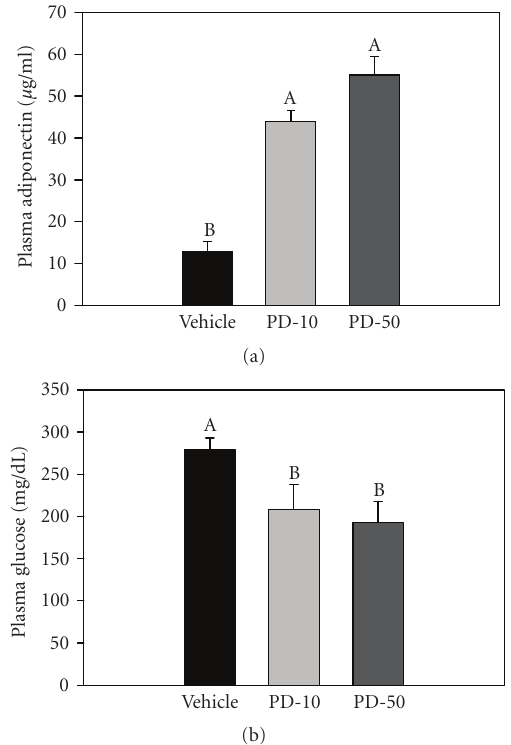
Figure 2: Plasma adiponectin (a) and serum glucose (b) levels in normal male SD rats chronically treated with vehicle (VEH), PD168 at a dose of 10 (PD-10) or 50 mg/kg · body weight (PD-50), ( n = 10/treatment group). Means were compared using one-way ANOVA followed by the Holm-Sidak multiple comparisons test. Data were represented as means ± SEM. Bars designated with “A” are significantly greater in value than bars designated with “B” and so forth (by Holm-Sidak). p < 0 . 05 was considered